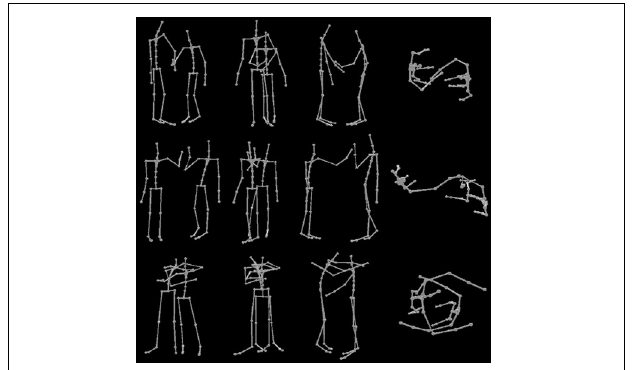
FIGURE 1 | Example stimuli for each viewpoint and action condition showing the last frame from an action movie used in the experiment. Different actions are shown across rows (handshake, high five, hug) and different viewpoints of the action are shown across columns (angled, behind, side, top).